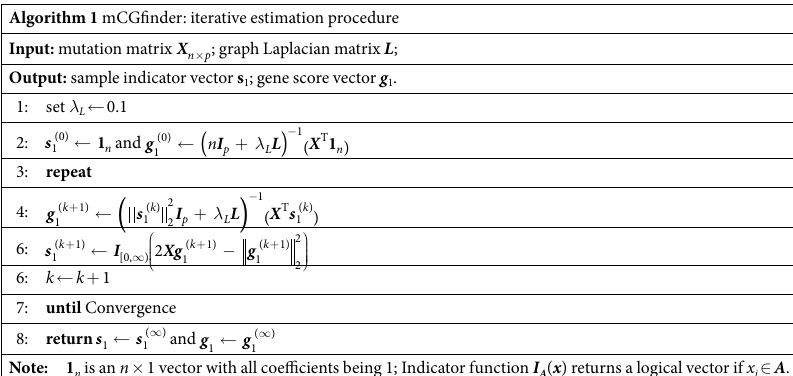
Algorithm 1 mCGfinder: iterative estimation